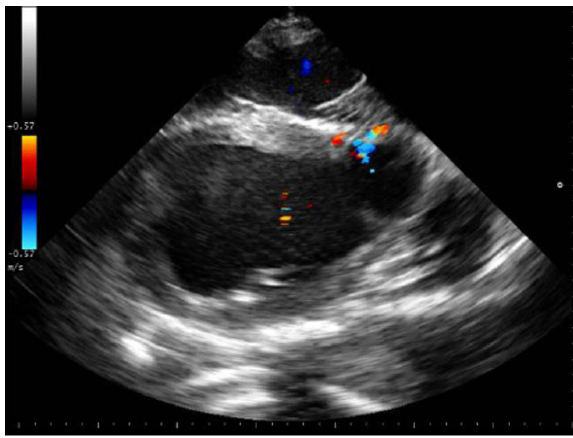
Figure 4. Oblique image of the LV showing transeptal flow in the region of the LV outflow tract.